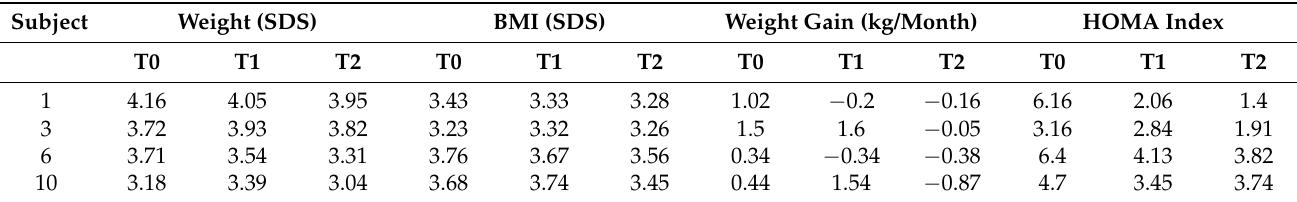
Table 4. Main data at T0-T1-T2 of the 4 subjects treated with metformin from